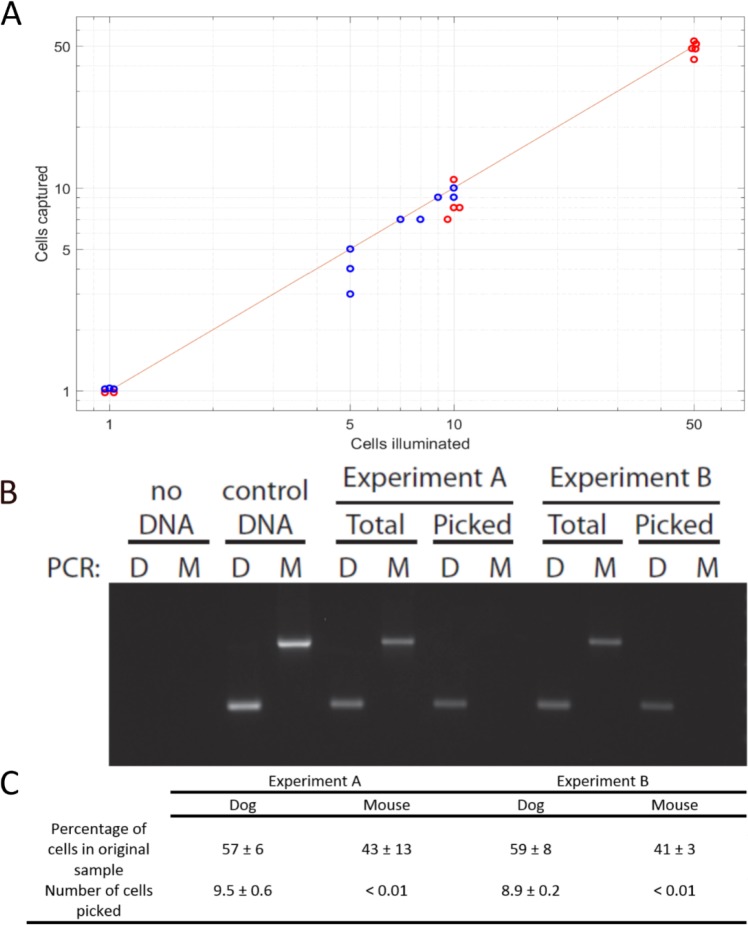
Capture efficiency and specificity.(A) Capture efficiency for 1, 5, 10, and 50 selected cells for a total of 27 experiments. Red dots represent experiments performed with glass as a cell culture substrate and blue dots correspond to experiments using Aclar as a substrate. The horizontal axis represents the number of target cells, considered as the number of cells illuminated with the laser. Ordinate axis shows the number of cells detected on the collection chamber after capture, and the line corresponds to 100% success rate. A linear fit of the data yielded a slope of 0.99, demonstrating that scMOCa is highly efficient in retrieving all target cells, after testing 1 to 50 cells. (B, C) Mouse (fluorescent) and dog (non-fluorescent) cell lines were co-cultured and only dog cells were illuminated and captured. PCR on a mitochondrial gene shows that all extracted cells form a pure sample and are exclusively dog cells. Table C shows the number of cells detected in each condition in three repeats of the experiment. These numbers are calculated from the amount of detected DNA normalized to the expected amount in one cell. A and B are independent experiments in which two different dishes were prepared, tagged and sorted prior to PCR.